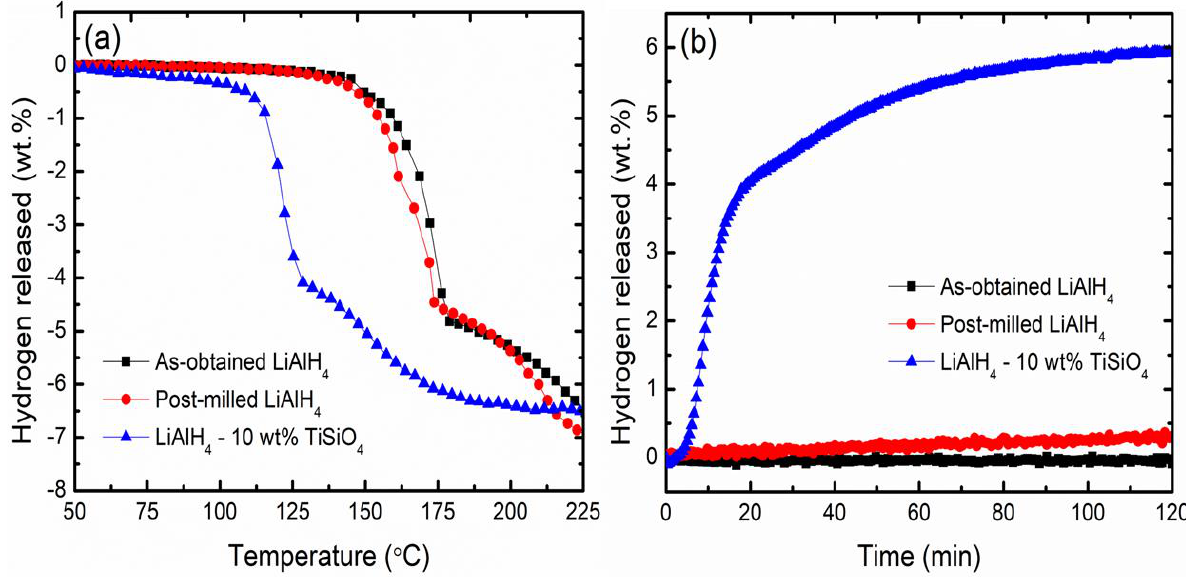
Figure 1. ( a ) TPD curve of as-obtained LiAlH 4 , post-milled LiAlH 4, and LiAlH 4 added with 10 wt% TiSiO 4 at 250 °C and ( b ) the dehydrogenation kinetics performance at a constant temperature of 90 °C for the added and undoped composites.